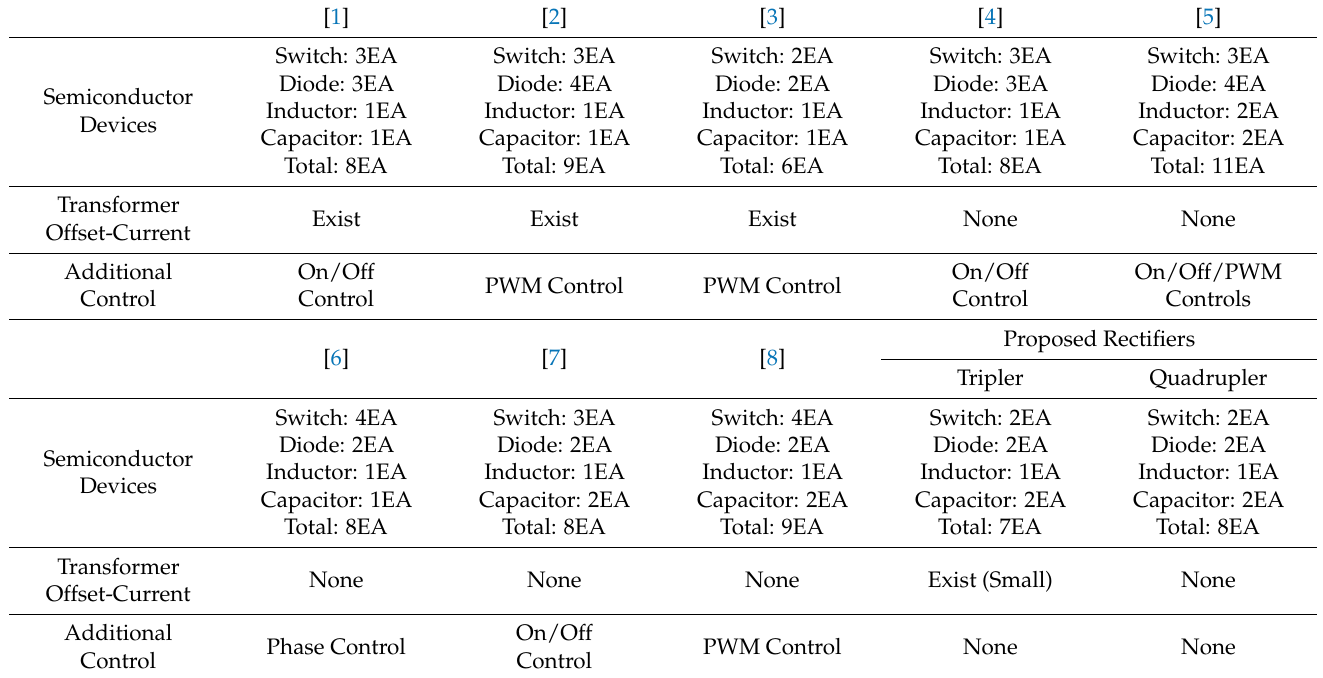
Table 1. Comparisons with prior